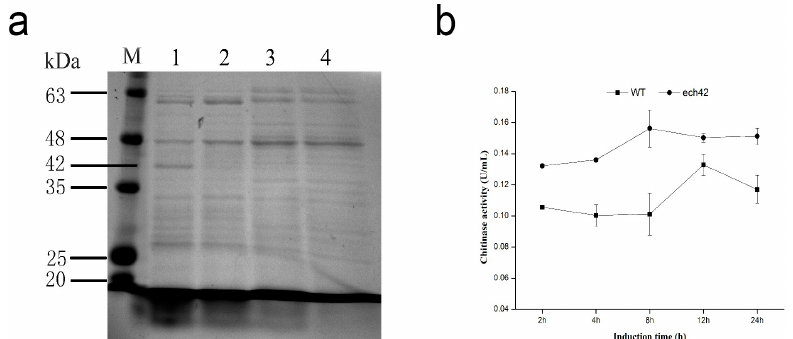
Figure 1. ech42 protein expression analysis of B. amyloliquefaciens and B. amyloliquefaciens -ech42. ( a ) SDS-PAGE showing the ech42 protein from B. amyloliquefaciens -ech42. M. Protein Marker; (1) B. amyloliquefaciens- ech42 induced by IPTG; (2) B. amyloliquefaciens -ech42 without IPTG induction; (3) B. amyloliquefaciens induced by IPTG; (4) B. amyloliquefaciens without IPTG induction; ( b ) Comparison of chitinase activities of B. amyloliquefaciens and B. amyloliquefaciens -ech42.